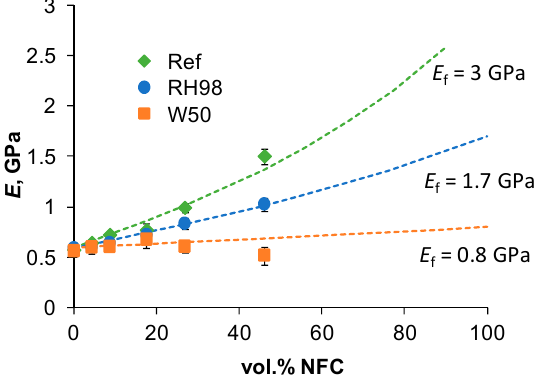
Figure 6. Elastic modulus as a function of NFC volume content for reference and aged samples. Lines are approximations by Equation (6) with different E f .